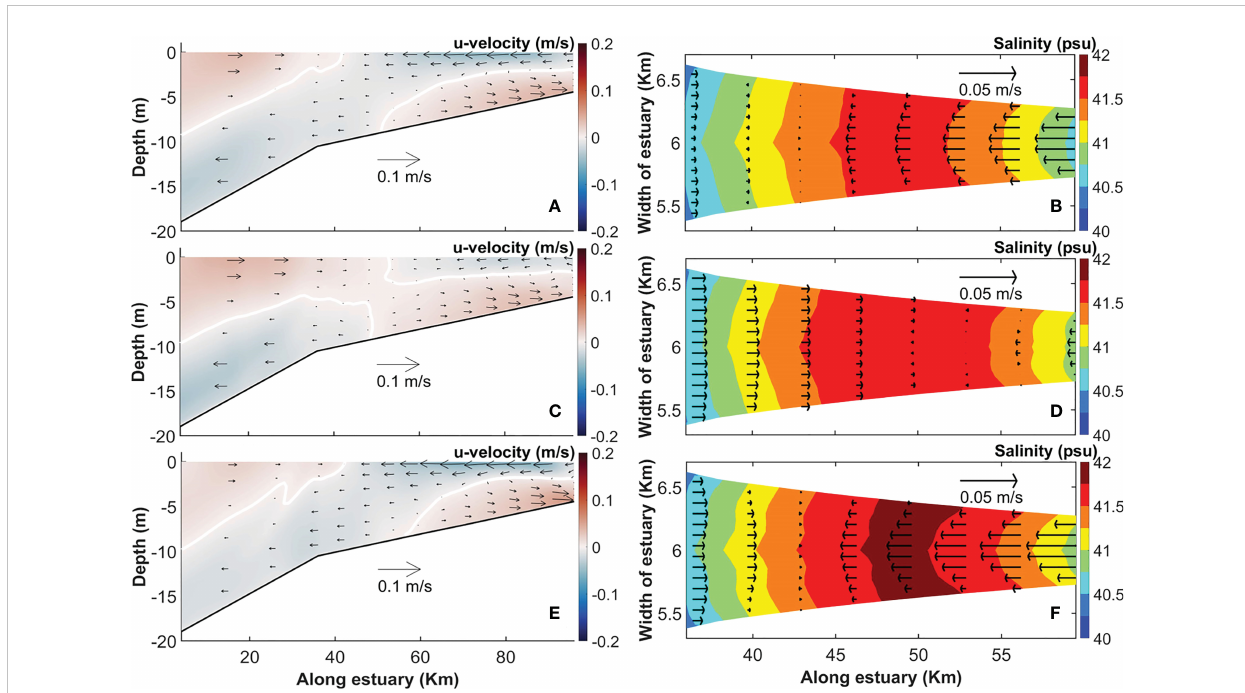
FIGURE 3 Along-channel pro fi les of axial velocity in EXP3 (see Table 1). Averaging is for the full neap – spring cycle of 28 days (A) , for six M2 periods during neap tide from 04 August to 07 August 2014 (C) , and for spring tide from 11 August to 14 August 2014 (E) . 2D distribution of surface axial-velocity and salinity corresponding with the periods of (A, C, E) are respectively presented in (B, D, F)